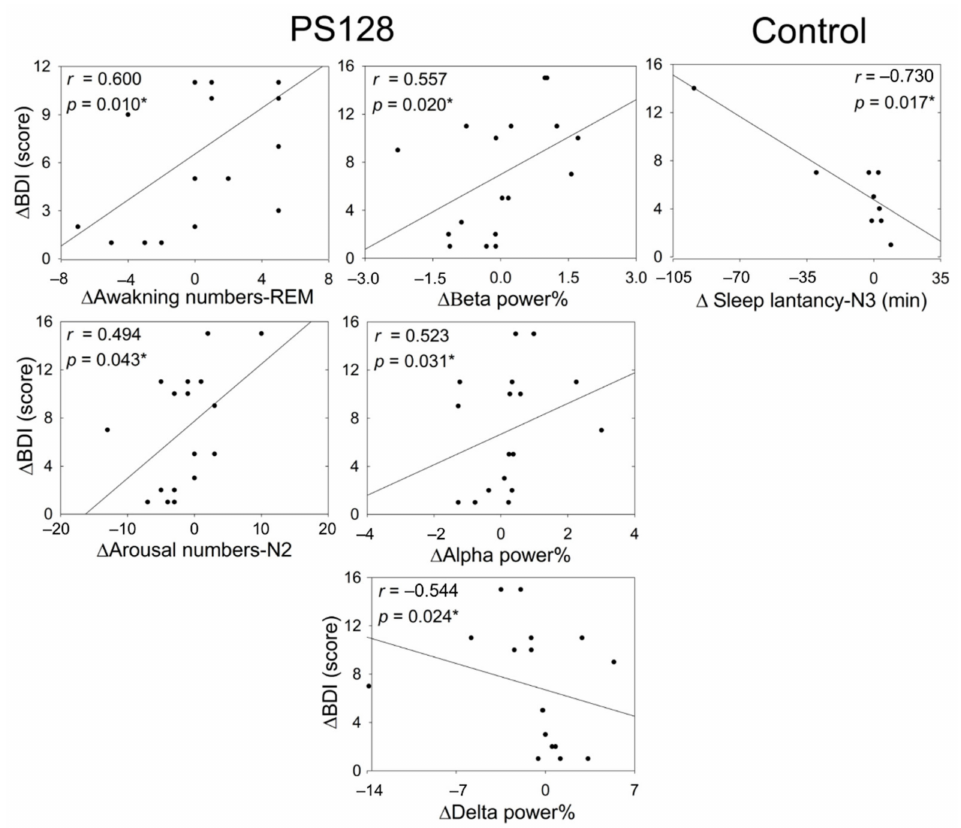
Figure 6. Two dimensional scatter plots displaying the relationship between the change in BDI-II scores and the change in objective parameters from baseline to 4 weeks of treatment. The figure shows those parameters that are correlated to the (cid:52) BDI. Control, n = 10; PS128, n = 17. * p < 0.05, Spearman rank correlation analysis. BDI-II, Beck Depression Inventory-II; REM, rapid eye movement stage; N2, non-REM (NREM) stage 2; N3, NREM stage 3; (cid:52) in scores as the day 0 score minus the day 30